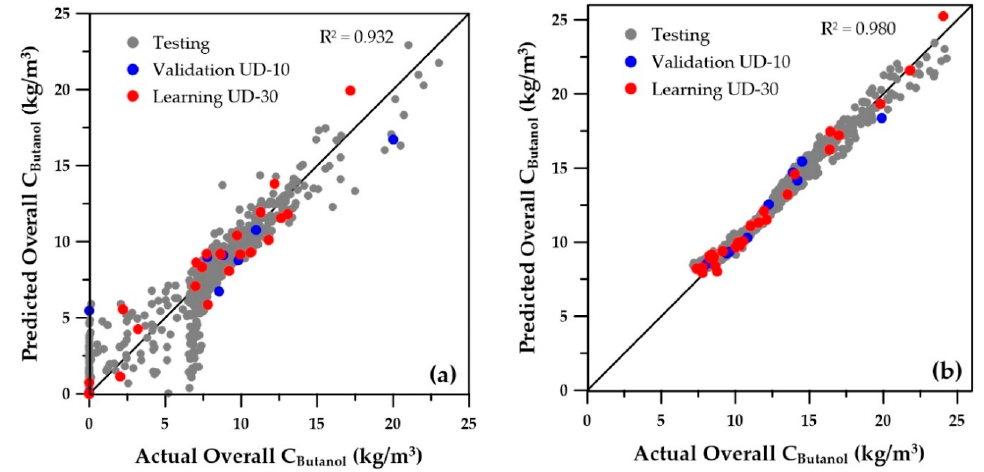
Figure 7. Predicted versus actual overall process butanol concentration for ( a ) initial ranges and ( b ) reduced ranges of the five decision variables.